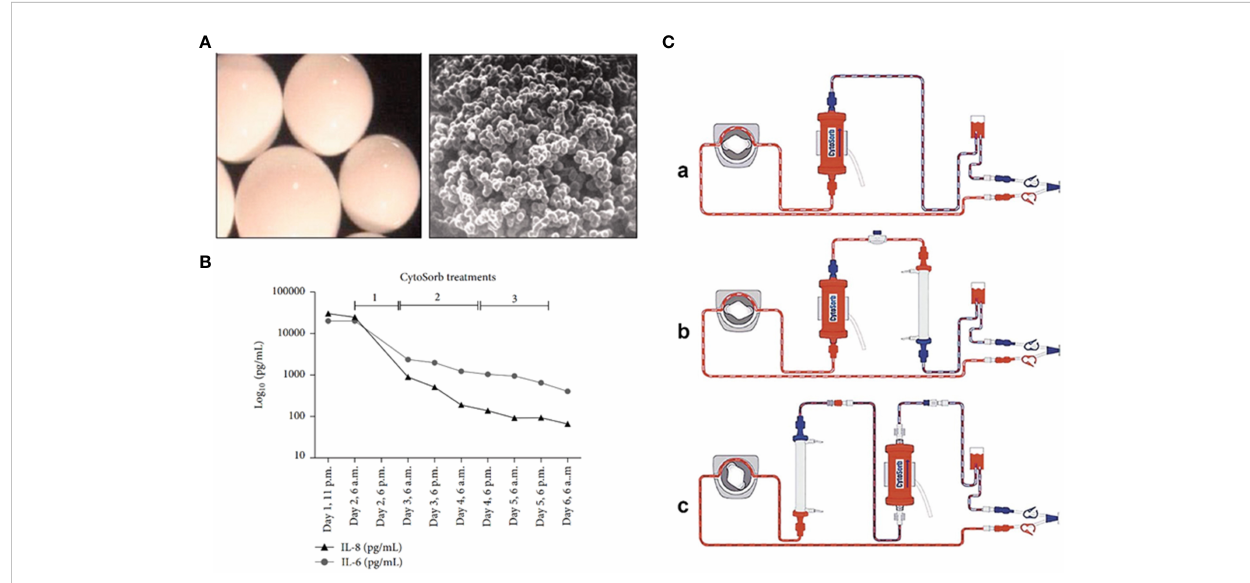
FIGURE 2 (A) Microscopic image for CytoSorb; (B) level of cytokines after incorporation of CytoSorb column; (C) formation of CytoSorb: (a) CytoSorb alone, (b) CytoSorb with pre dialyzer, (c) CytoSorb with post dialyzer. Reproduced with permission from (76 –